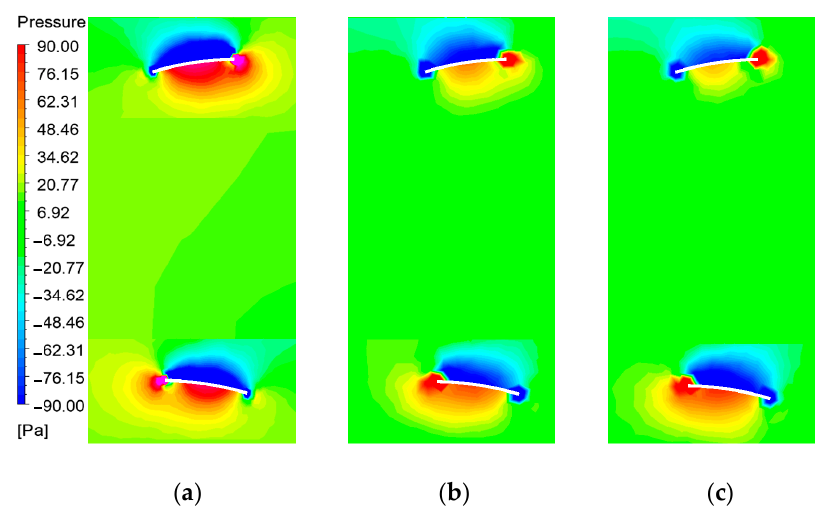
Figure 12. The vertical pressure contour of rotor tip in a coaxial rotors unit (2200 r / min): ( a ) 0 m / s; ( b ) 2.5 m / s; ( c ) 4 m / s.